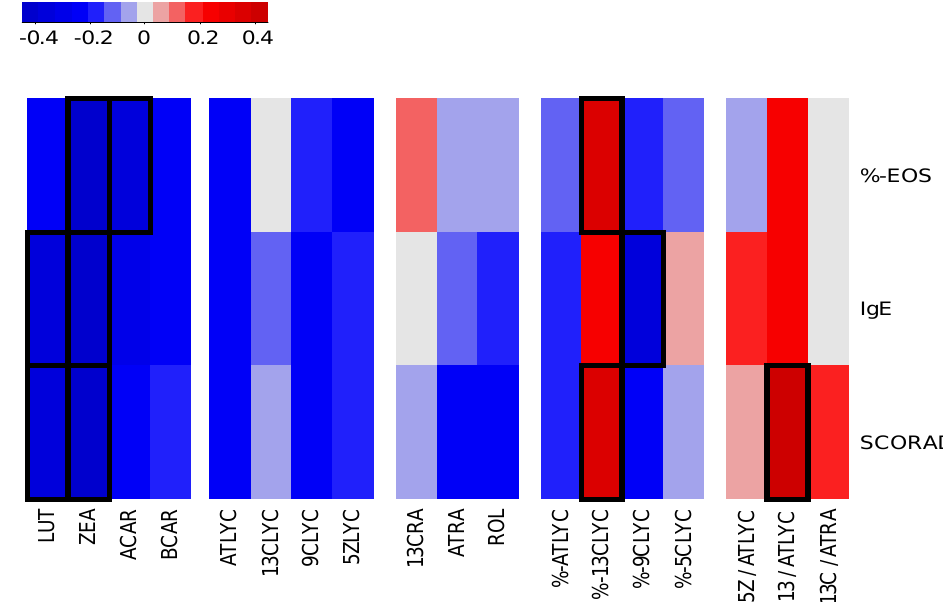
Figure 1. In this clustered image map analysis individual correlations between two values are displayed based on the determined concentrations and calculated ratios and percentile amounts originating from n = 40 individuals (healthy volunteers and AD-patients). A specific correlation value is indicated by a two-dimensional colored image (red to blue), where each entry of the matrix is colored on the basis of its correlation value indicated by the displayed color legend in a distance matrix analysis from plasma levels of the carotenoids zeaxanthin (ZEA), lutein (LUT), β -carotene (BCAR), α -carotene (ACAR), all- trans -lycopene (ATLYC), 13- cis -lycopene (13CLYC), 9- cis -lycopene (9CLYC), 5- cis -lycopene (9CLYC) and the retinoids 13- cis -retinoic acid (13CRA), all- trans -retinoic acid (ATRA), retinol (ROL) levels in addition to calculated ratios and percentile amounts of selected carotenoids or retinoids with the clinical AD-markers, like number of eosinophils as percentage from PBMCs (%-EOS), plasma total IgE levels in kilounits per liter (IgE), and SCORAD units [45,46]. Significant correlations are indicated by a p > 0.05 and were additionally marked by a black frame.